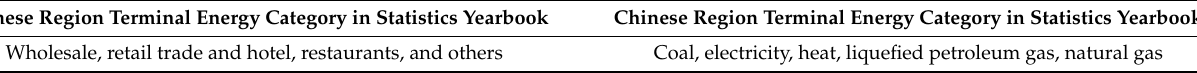
Table 3. Specific accounting boundary of public